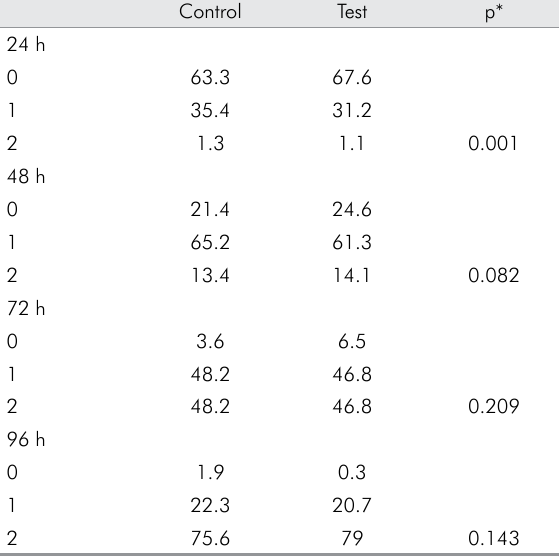
Table 1. Mean percentage of surfaces with Plaque Free Zone Index scores of 0, 1 and 2, considering all the surfaces at each experimental